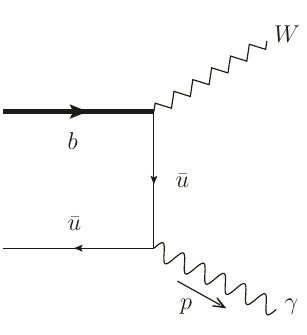
Figure 1 . Leading contribution to B ! (cid:13)‘(cid:23) ‘